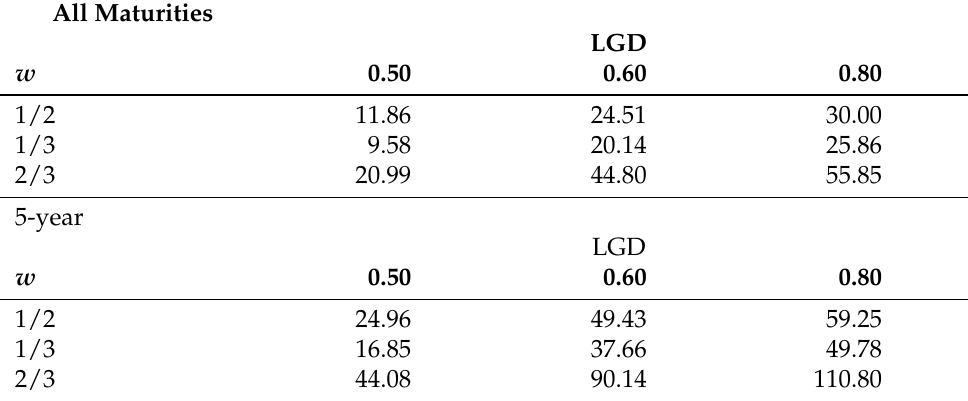
Table 5. Average absolute mean errors (expressed in basis points). Considering both all maturities and the 5-year maturity only, which is the most liquid, the error is smallest for the aggregation scheme w = 1/3. Additionally, setting LGD = 0.5 makes the pricing error smallest. As expected, the largest average pricing error is for the scheme w = 2/3, which puts a lot of debt expiring in the short-term (which is unlikely to be for most of the companies). Reported figures are weighted averages in which the weights are the numbers of companies in each leverage